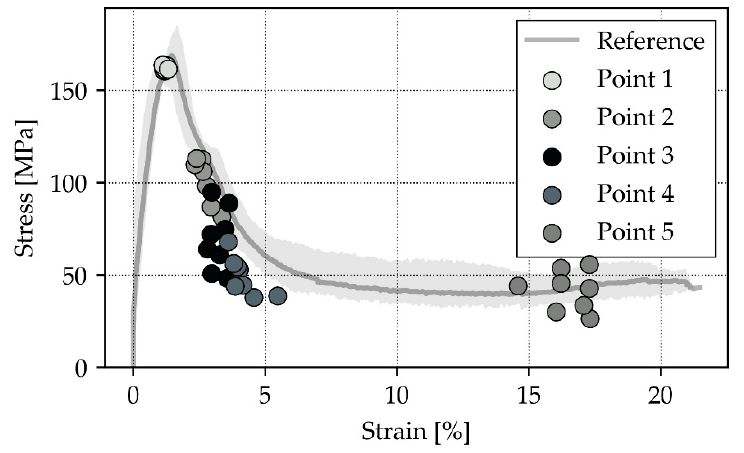
Figure 1. Stress–strain envelope of a [45, − 45, 0] s compression-loaded laminate. Points indicate the end state of a loading cycle before being CT scanned. Specimen count: 8.